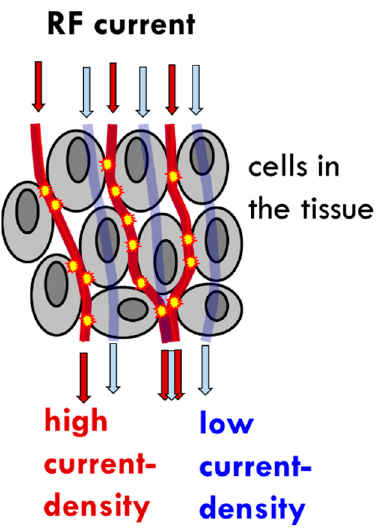
Figure 2. Nano-heating: schematic representation of the flow of current through malignant tissue, between the cells, and the absorption of the energy in the membrane rafts, leading to areas of high current density.